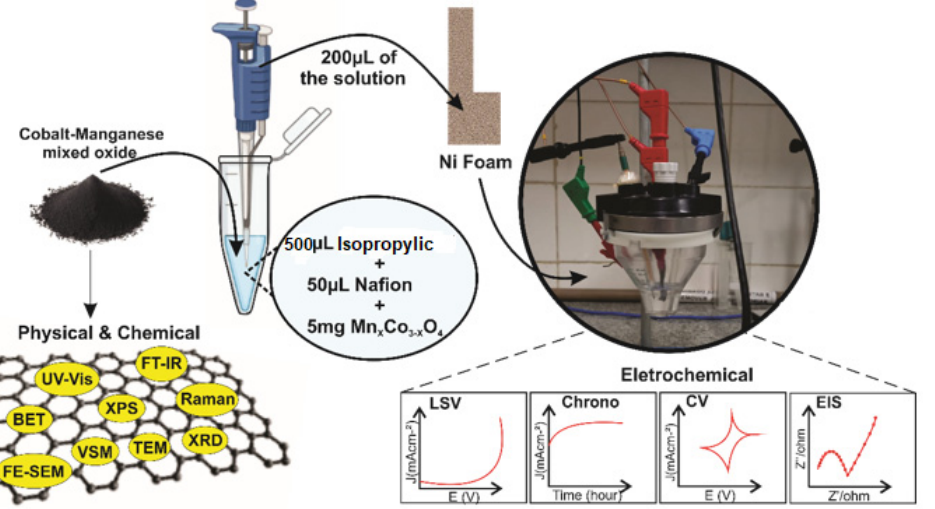
Figure 2. Physical, chemical, and electrochemical characterization of Mn X Co 3-X O 4 (0 ≤ X ≤ 1).